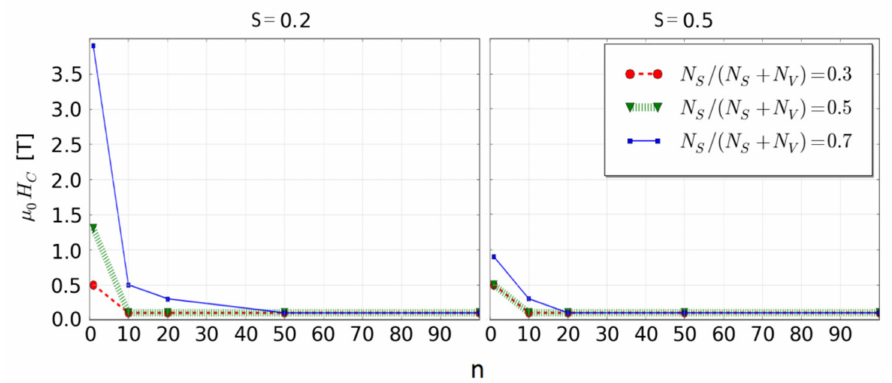
Figure 7. Coercive field H C as a function of the scaling factor for the systems presented in Figure 6.